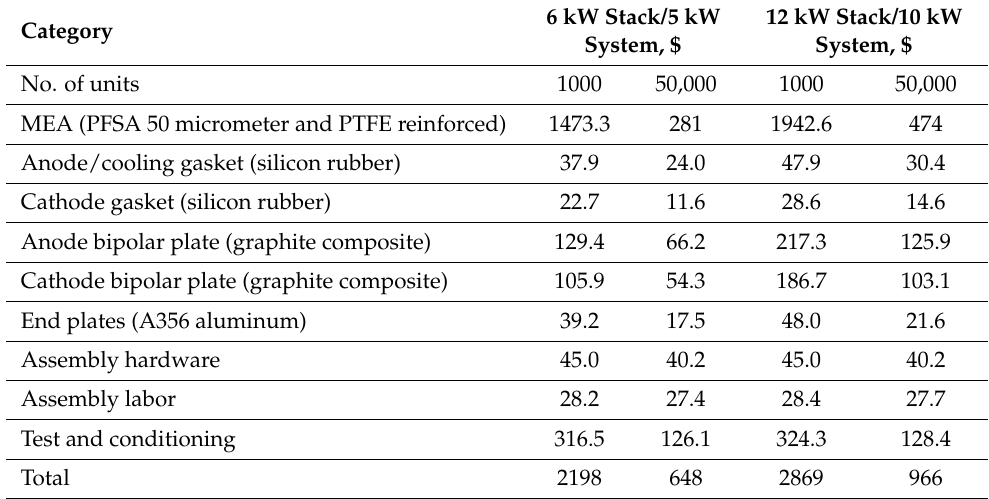
Table 1. PEMFC stack component cost summary (at 0.15 mg Pt/cm 2 catalyst loading)